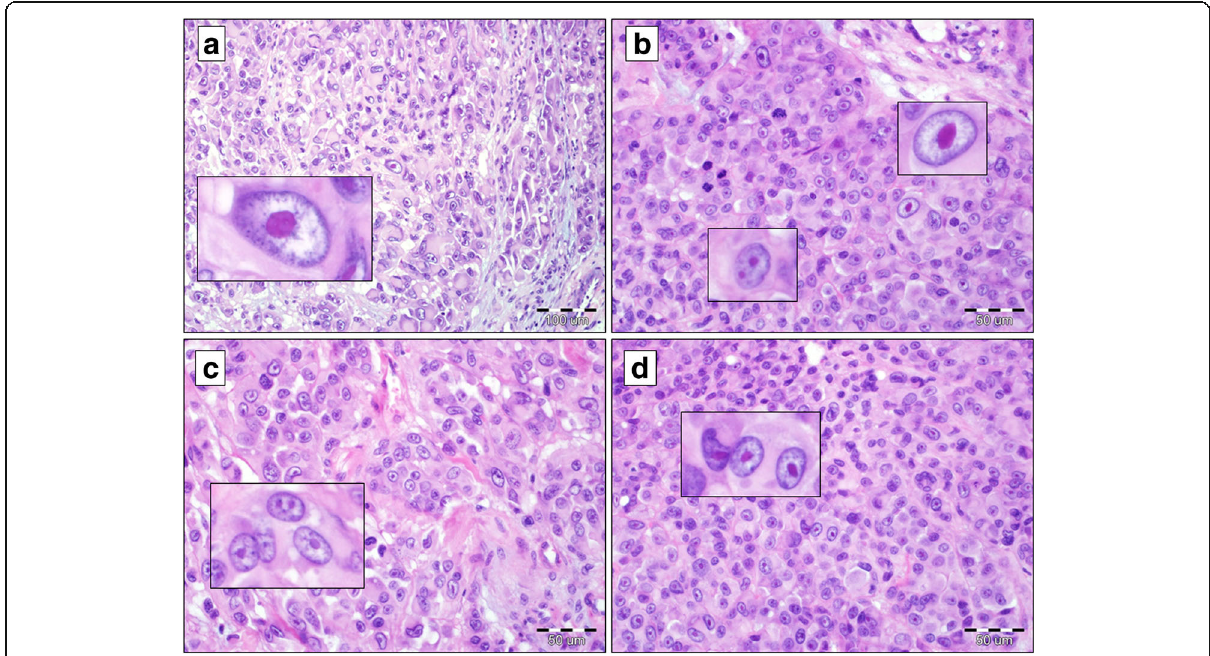
Fig. 2 Cytomorphology of nucleoli in cutaneous melanoma cells. Prominent macronucleoli in melanoma cells (( a ), H&E staining, ×400; insert: eosinophilic roundish macronucleolus, H&E staining, ×600). Melanoma cells of high heterogeneity in the context of cytomorphological parameters of the nucleoli – cells with micronucleoli and cells with prominent macronucleoli present (( b ), H&E staining, ×400; insert: H&E staining, ×600). High representation of cancer cells with distinct nucleoli with the feature of binucleolization (( c ), H&E staining, ×400; insert: H&E staining, ×600; ( d ) staining, ×400; insert: eosinophilic micronucleoli, H&E staining,